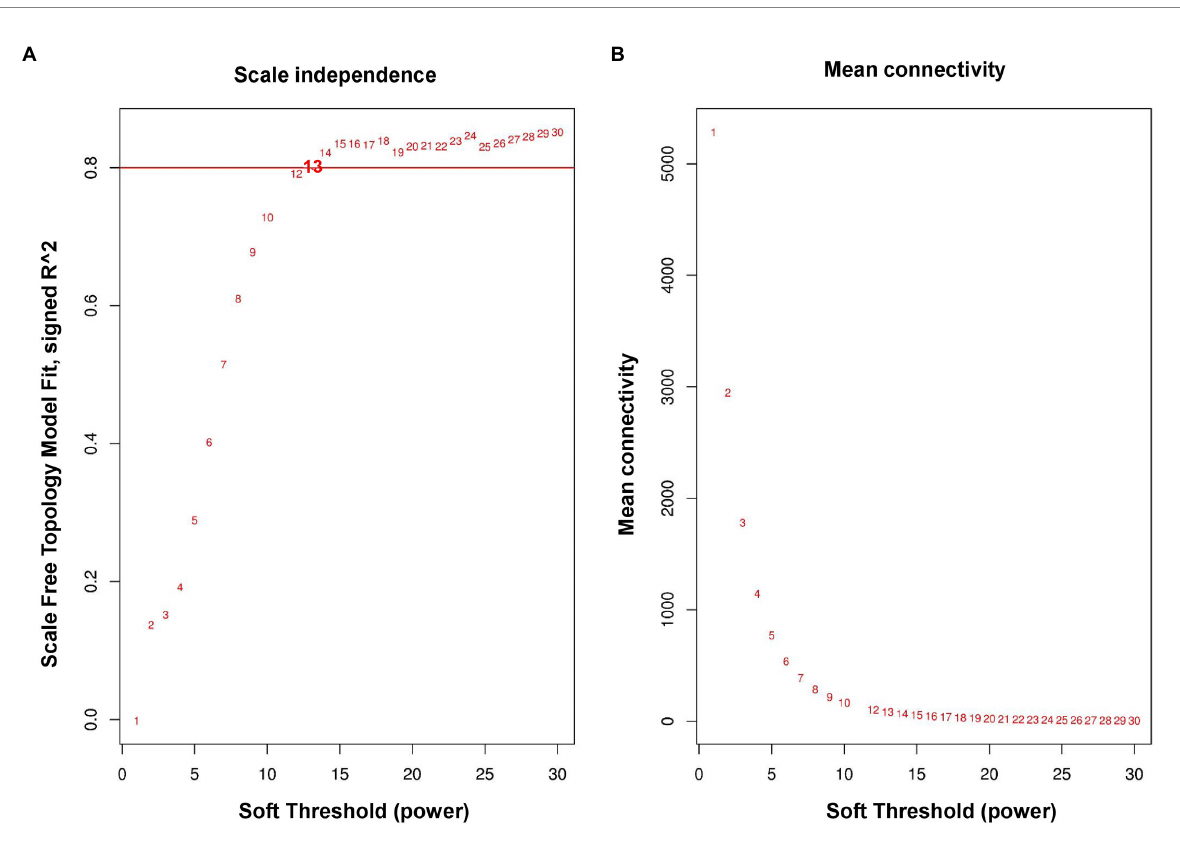
FIGURE 3 Network topology analysis. (A) Scale-free topology fitting index ( R 2 ) ( y -axis) and (B) mean connectivity ( y -axis) for different soft-threshold powers ( β ) ( x -axis). The weighted gene co-expression network was constructed at β = 13, which represents a scale free topology fitting index ( R 2 ) ≥